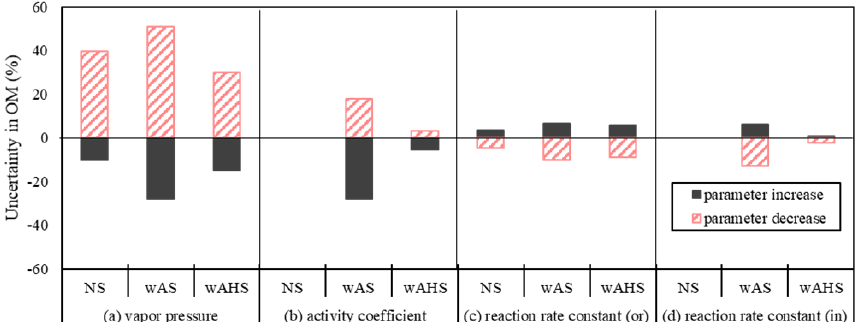
Figure 7. Uncertainties in UNIPAR-CB6r3 simulated gasoline SOA mass due to model parameters: (a) vapor pressure ( P L ,i ), (b) activity coefficient in inorganic phase ( γ i n ), (c) aerosol-phase reaction rate constant in organic phase ( k o ), and (d) aqueous-phase reaction rate constant ( k AC ). The errors associated with P L ,i , k AC , and k o were estimated by increasing and decreasing the factors by 150% and 50%. The uncertainties associated with γ in were estimated through increasing and decreasing γ in by 200% and 50%, respectively. The SOA formation was simulated at the high NO x level (HC / NO x = 3ppbCppb − 1 ) under the given reference conditions (298K, 60%RH, and 1500ppbC of gasoline vapor) under the specific sunlight intensity measured on 19 June 2015 (Fig. S5a). The concentration of pre-existing organic matter and inorganic seed was 3 and 10µgm − 3 ,